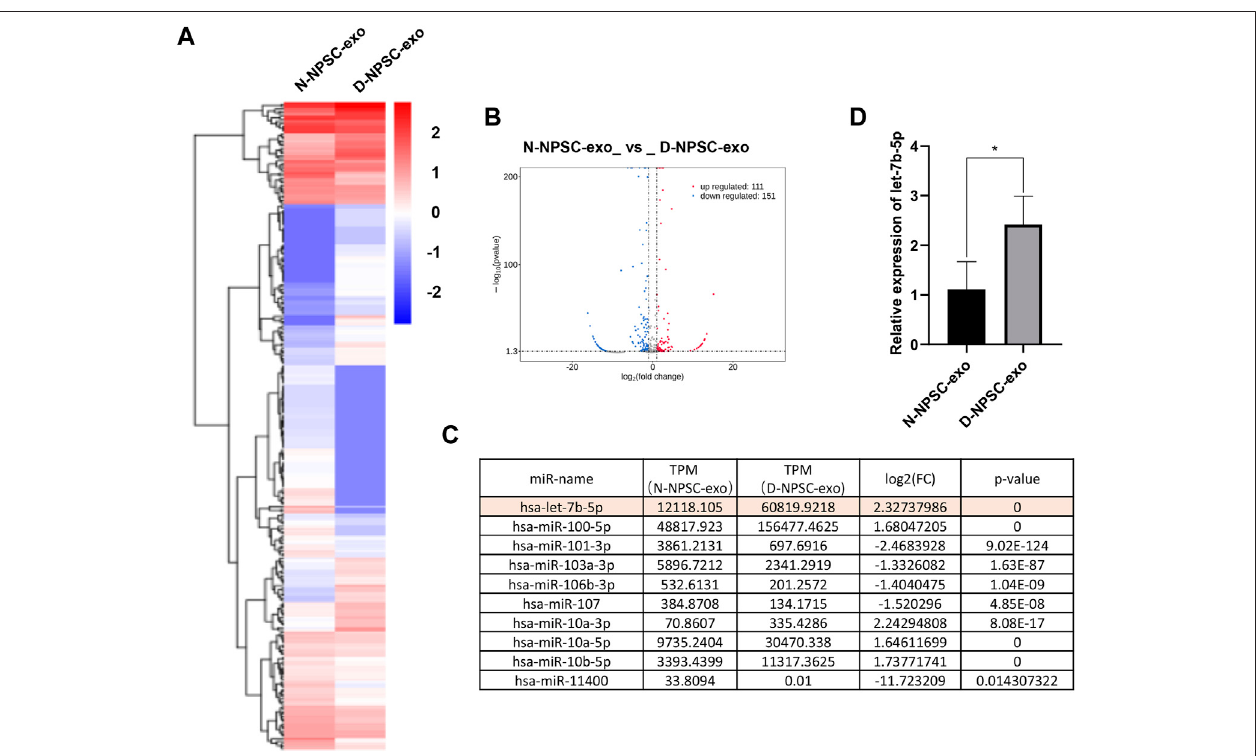
FIGURE 3 | Pro fi ling of the expression of miRNA in N-NPSC-exo and D-NPSC-exo. (A) The miRNA pro fi les of N-NPSC-exo and D-NPSC-exo are represented in the heatmap and hierarchical clustering-based dendrograms. (B) Volcano plot showing up- and downregulated miRNAs in N-NPSC-exocompared with D-NPSC-exo. (C) Fold changes observed in miRNA expression in N-NPSC-exo compared with D-NPSC-exo on microarray data. (D) Real-time PCR of hsa-let-7b-5p in N-NPSC-exo compared with D-NPSC-exo. * p < 0.05; ** p <